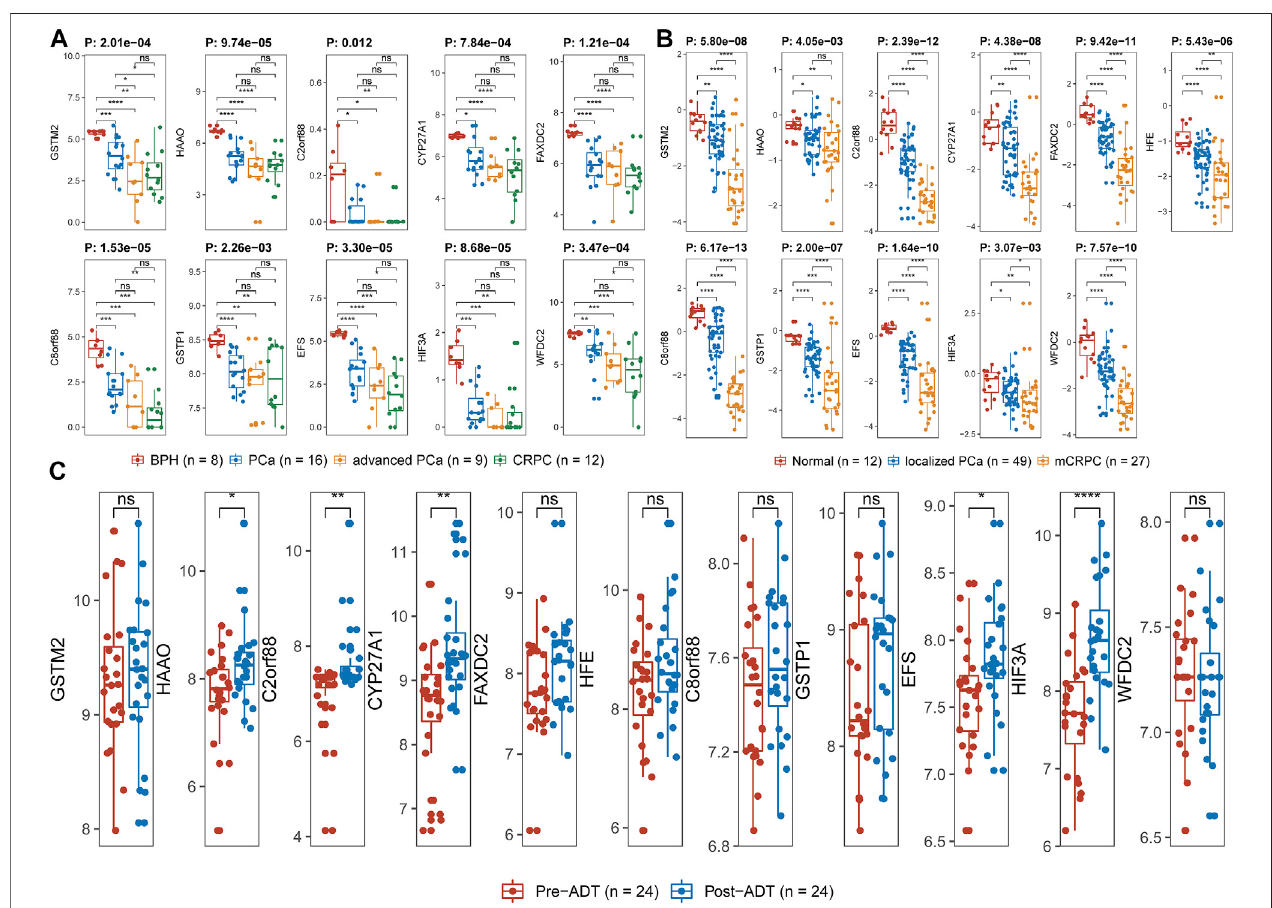
FIGURE 10 | Exploration of expression levels of driver genes across varied stages of PCa. (A) GSE80609, (B) GSE35988, and (C) GSE111177. Wilcoxon rank- sum test was applied between two groups. Kruskal – Wallis rank-sum test was used for more than two groups. Label (*) means p < 0.05, label (**) means p < 0.01, and label (***) means p <